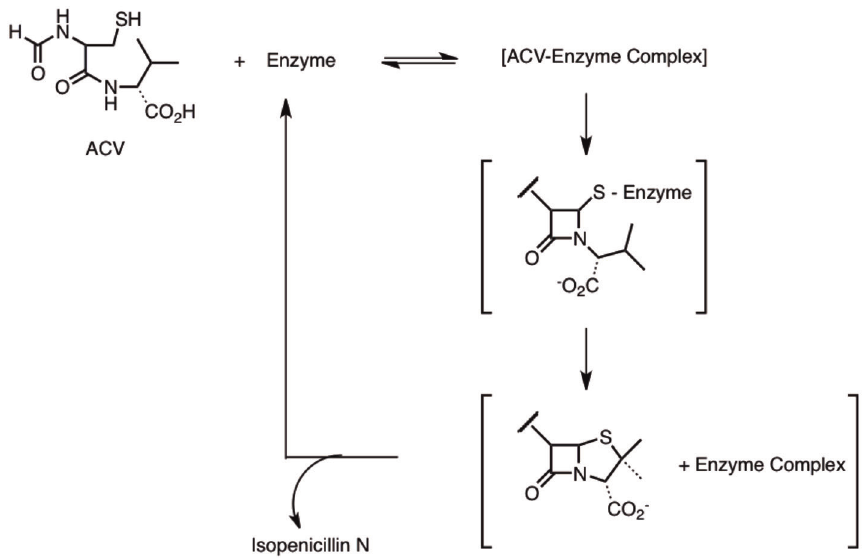
Figure 21 - Transformation of δ -(L- α -aminoadipoyl)-L-cysteinyl-D-valine into isopenicillin